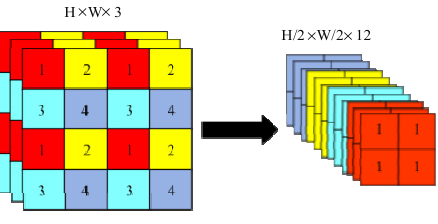
Figure 4. The focus module.